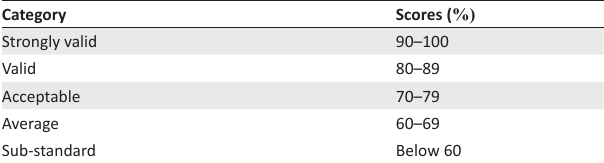
TABLE 1: Department of Education moderation